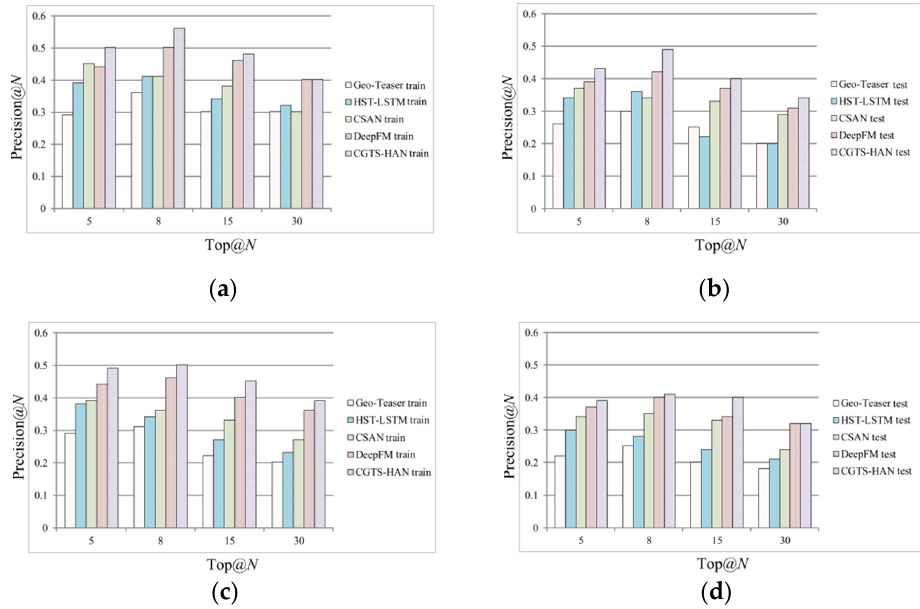
Figure 5. Comparison Results of Precision with N : ( a ) Precision of train on Foursquare; ( b ) Precision of test on Foursquare; ( c ) Precision of train on Yelp; ( d ) Precision of test on Yelp.